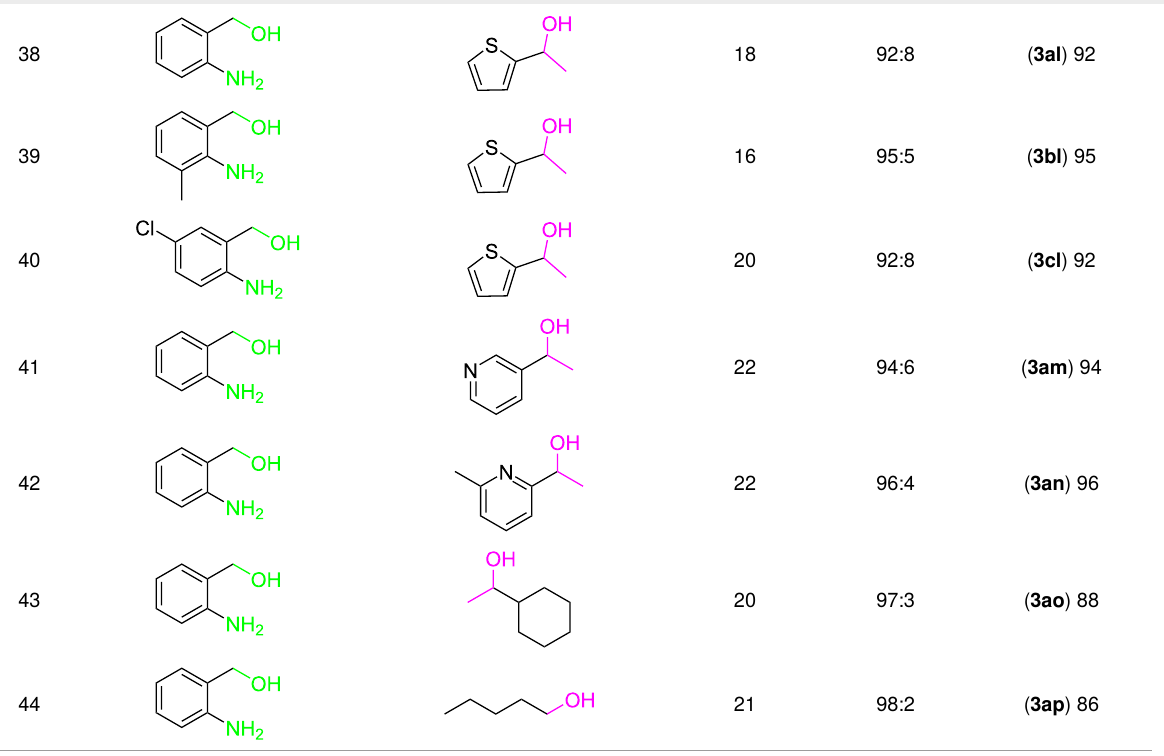
Table 3: Cyclometalated iridium-catalyzed ADC reaction of various 2-aminobenzyl alcohols and secondary alcohols. a (continued)